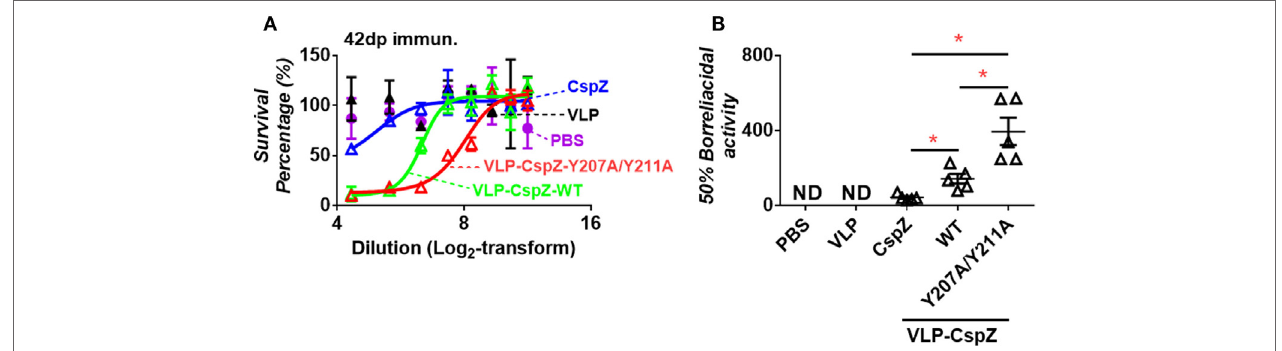
FigUre 3 | Serum from mice immunized with VLP-CspZ-Y207A/Y211A had more robust levels of bactericidal activity than VLP- or VLP-CspZ-vaccinated mice. Serum collected five C3H/HeN mice at 42 days post inoculation of virus-like particle (“VLP”), CspZ (“CspZ”), VLP-CspZ (“VLP-CspZ-WT”), or VLP-CspZ-Y207A/ Y211A (“VLP-CspZ-Y207A/Y211A”) was mixed at indicated dilutions with guinea pig complement and 5 × 10 5 cells/mL Borrelia burgdorferi strain B31-A3. The serum collected from three C3H/HeN mice at 42 days post inoculation of PBS was also included as negative control. Surviving spirochetes were quantified using dark-field microscopy after 24-h of incubation. (a) The survival percentage was derived from the proportion of serum-treated to untreated B. burgdorferi. Data shown are the mean ± SEM of survival percentage derived from three fields under the microscope for each sample. (B) The 50% borreliacidal titer of each serum sample, representing the dilution rate of the serum that effectively killed 50% of spirochetes, was obtained from the cure-fitting in Panel (a) (see Materials and Methods). Data shown are the mean ± SEM of borreliacidal titers of each serum sample derived from five CspZ, VLP-CspZ, or VLP-CspZ-Y207A/Y211A mice per group. The 50% borreliacidal titers of the serum samples from PBS- or VLP-inoculated mice were not detectable (“ND”) as those serum samples displayed no bactericidal activity. Statistical significances ( p < 0.05) of differences in bactericidal titers relative to CspZ-immunized mice were determined using a t -test and